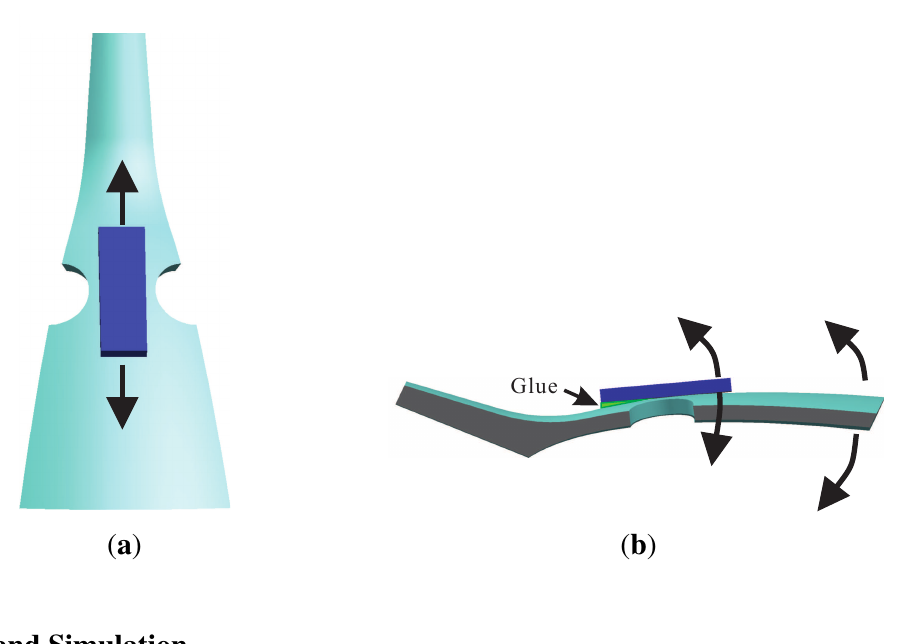
Figure 7. Schematic of piezoelectric work principle. ( a ) Contract and Expand Force. ( b ) Bend